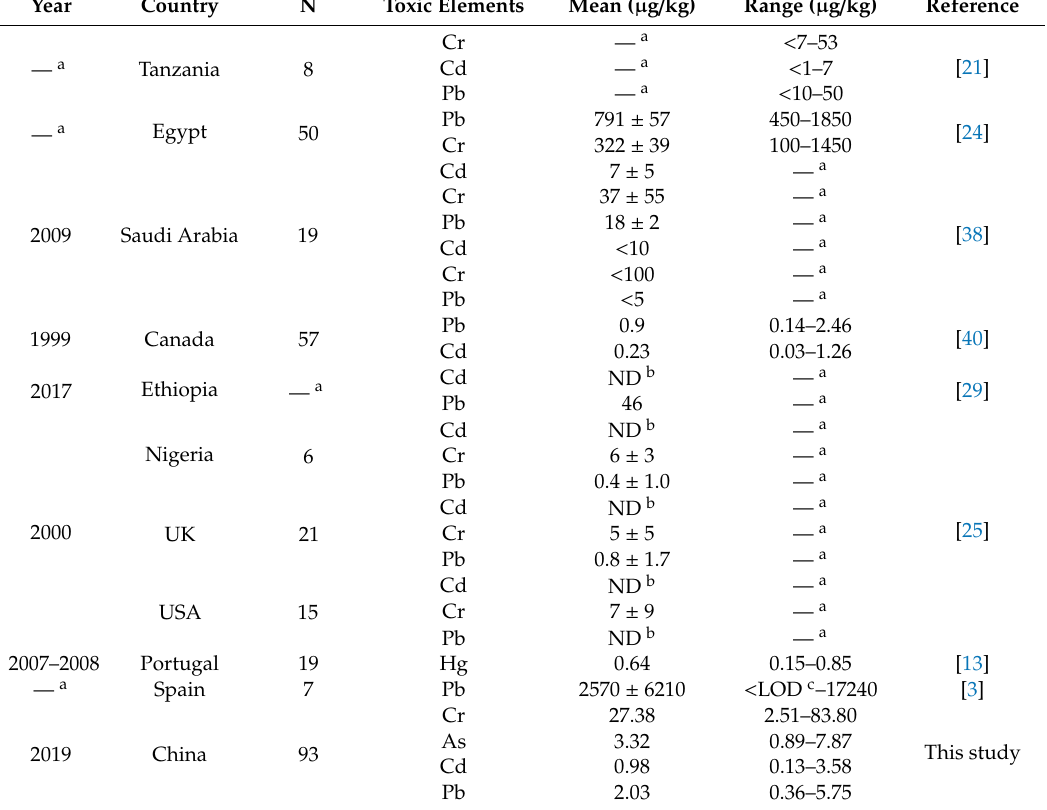
Table 6. Toxic elements content in infant formulas from di ff erent